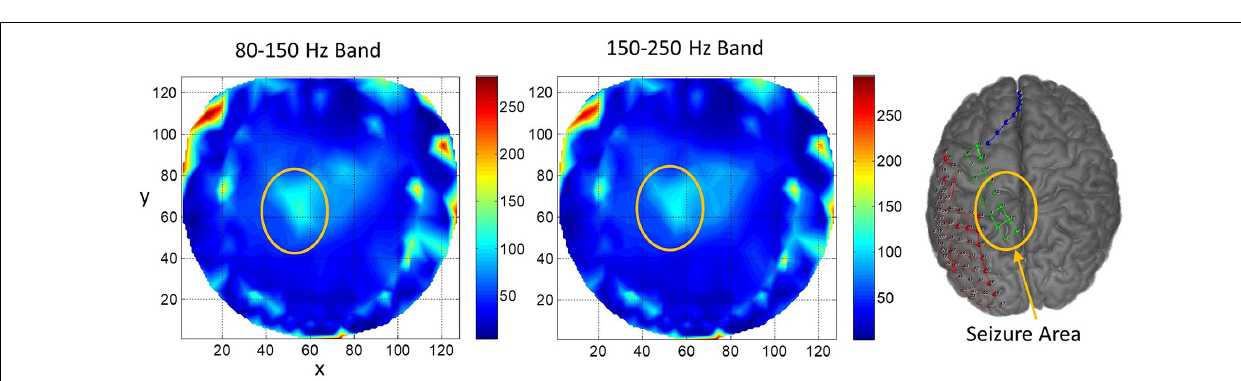
FIGURE 4 | The rate of formation (counts/s) of stable phase cone clusters averaged over a 240-s interictal period for the subject #2 in the 80–150 and 150–250 Hz bands are given in the left and middle plots, respectively. The color bar indicates the rate in counts/s. (Right plot) The grid and strip electrodes layout for ECoG data collection. The yellow-orange ellipse marks the area where seizures and epileptogenic activities were